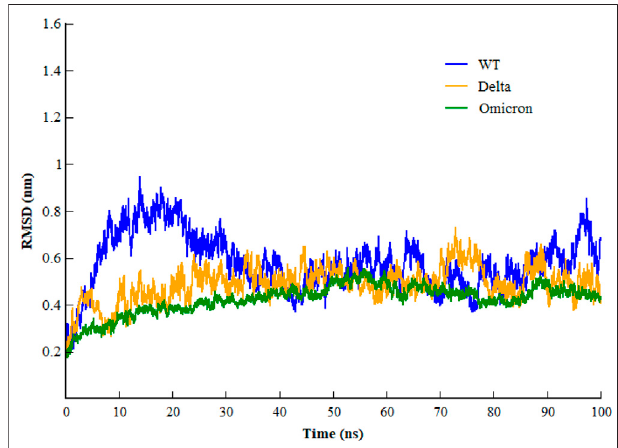
FIGURE 2 | Root mean square deviation of backbone carbon atom of SARS-CoV-2 WT, Delta, and Omicron variants during the course of 100 ns of simulation.